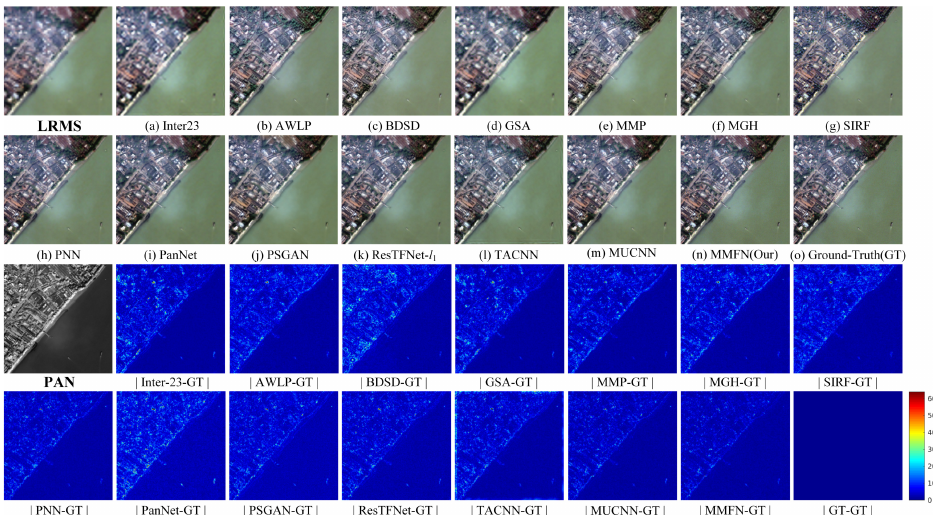
Figure 3. Qualitative comparison at reduced resolution on the QuickBird dataset. ( a ) Inter23, ( b ) AWLP, ( c ) BDSD, ( d ) GSA, ( e ) MMP, ( f ) MGH, ( g ) SIRF, ( h ) PNN, ( i ) PanNet, ( j ) PSGAN, ( k ) ResTFNet- l 1 , ( l ) TACNN, ( m ) MUCNN, ( n ) MMFN, ( o ) Ground-Truth (GT). The last two rows are MAEs between pansharpened results and the related ground-truth images.